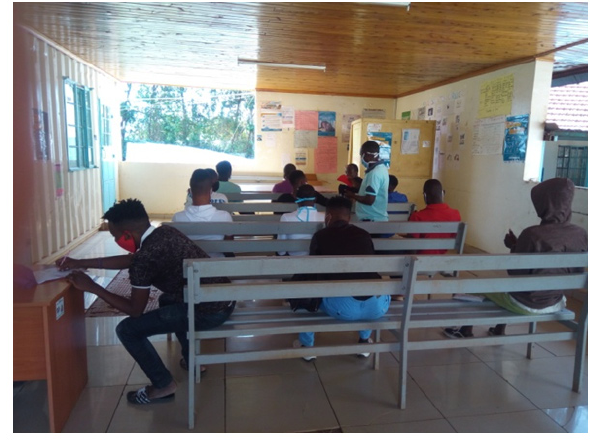
Figure 6. Clients maintaining physical distancing in the public health facility in Kiambu